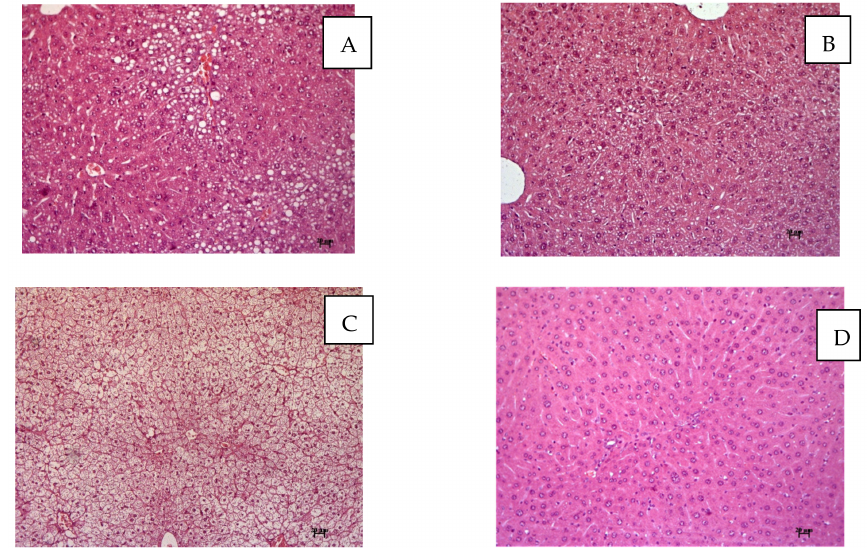
Figure 5. Histological evaluation of liver in mice after 4 weeks of experiment. ( A ) AY mice (untreated), ( B ) AY mice treated using metformin at a dose of 250 mg/kg, ( C ) AY mice treated using compound 2e at a dose of 15 mg/kg, ( D ) C57Bl/6 (healthy control). Hematoxylin and eosin staining, ×